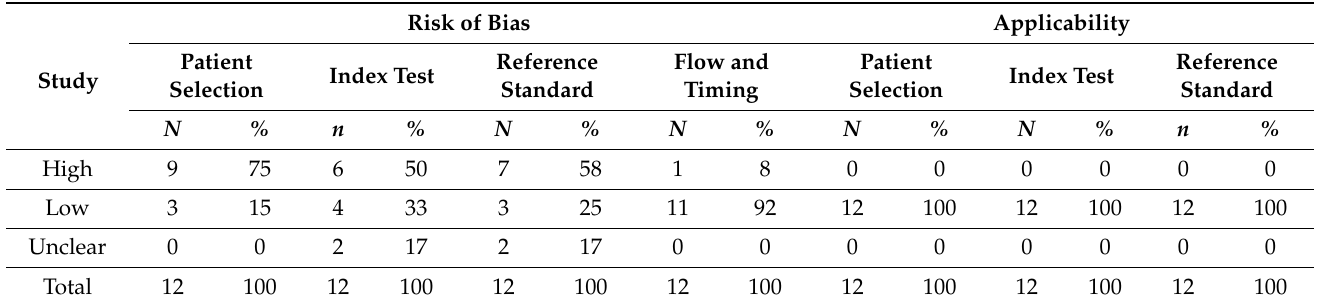
Table 1. Methodological quality table.